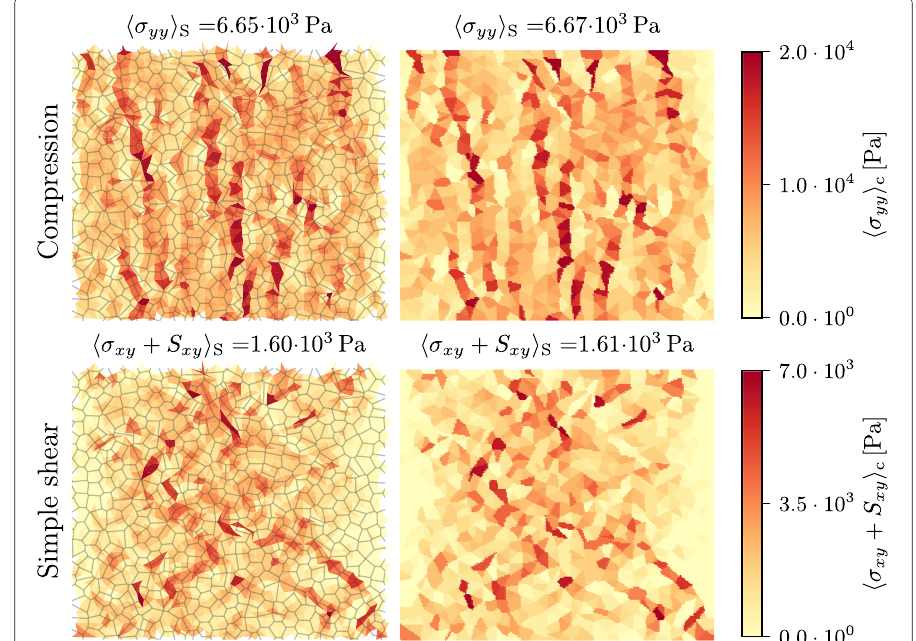
Fig. 2 Stresses in the control volumes (left) and nearest-neighbor interpolation (right) in beam networks, system parameters: H = 19 (cid:2) p and β = 0.3; top: compressive loading, bottom: shear loading; in the left-hand images the microstructure is shown in the background in